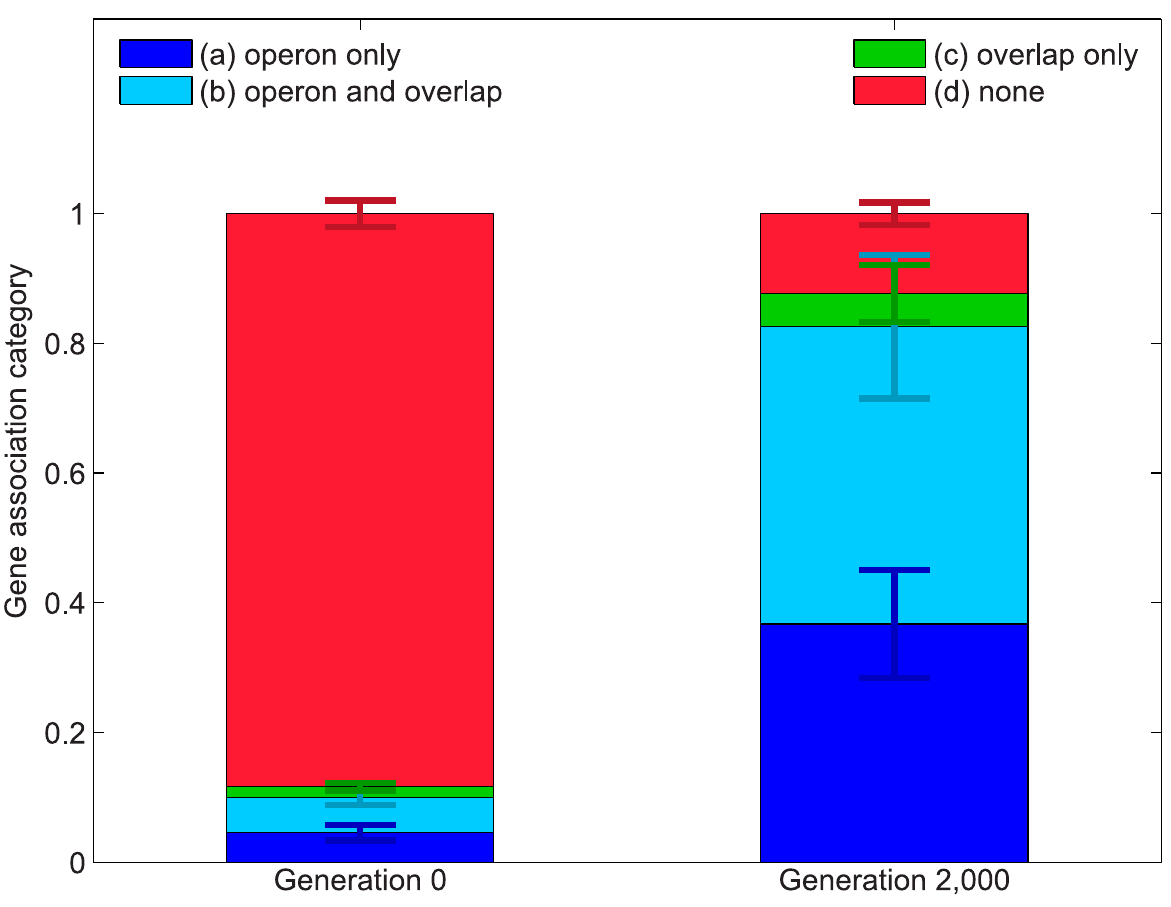
Figure 4. Secretion genes at generation 0 and at generation 2,000 partitioned between four categories: (a) sharing a promoter ( i : e : being on the same operon) without overlapping with a metabolic gene (dark blue), (b) overlapping and sharing an operon with a metabolic gene (light blue), (c) overlapping without sharing an operon with a metabolic gene (green), (d) neither sharing an operon nor overlapping with a metabolic gene (red). Error bars represent one standard error of the mean (fifty original cooperators). The color of the error bars corresponds to the genetic architecture category which they relate to.